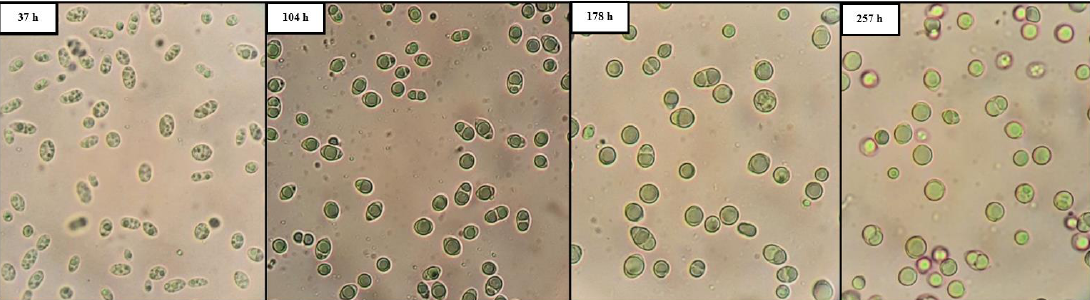
Figure 4. Representation of lipid accumulation progress of Cryptococcus curvatus ATCC 20509 fed- batch cultivation in treated second CW supplemented with added CW-derived lactose.